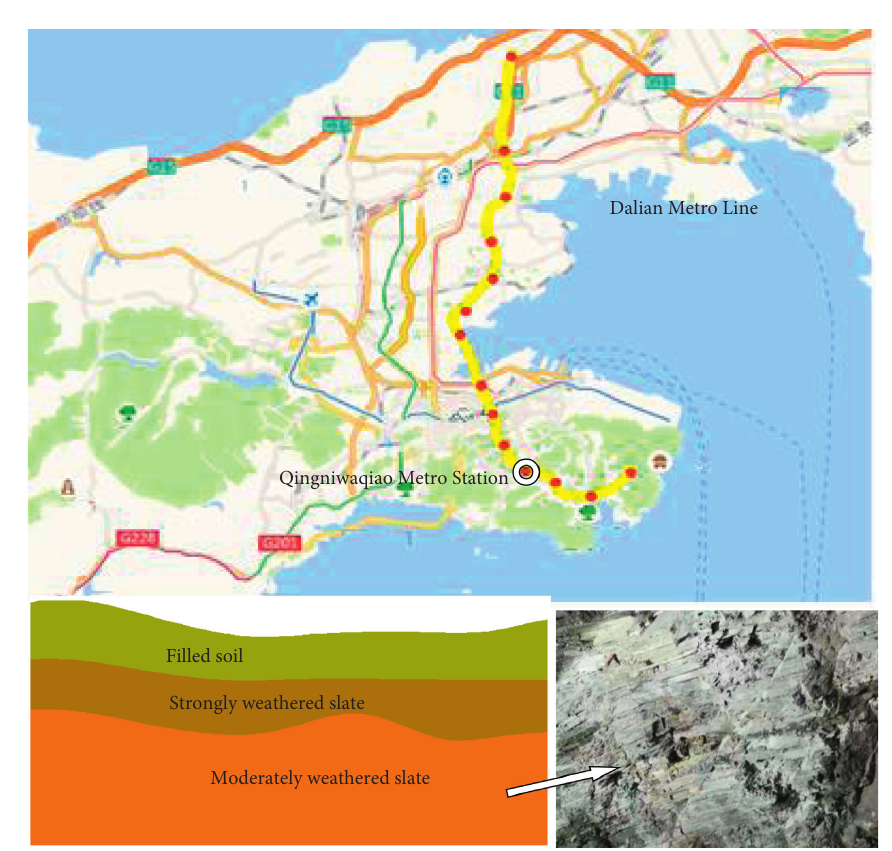
Figure 2: Location and geological condition of the